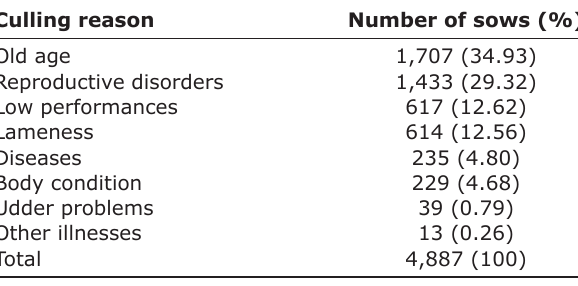
Table-2: The number and frequency (%) of sow culling by removal